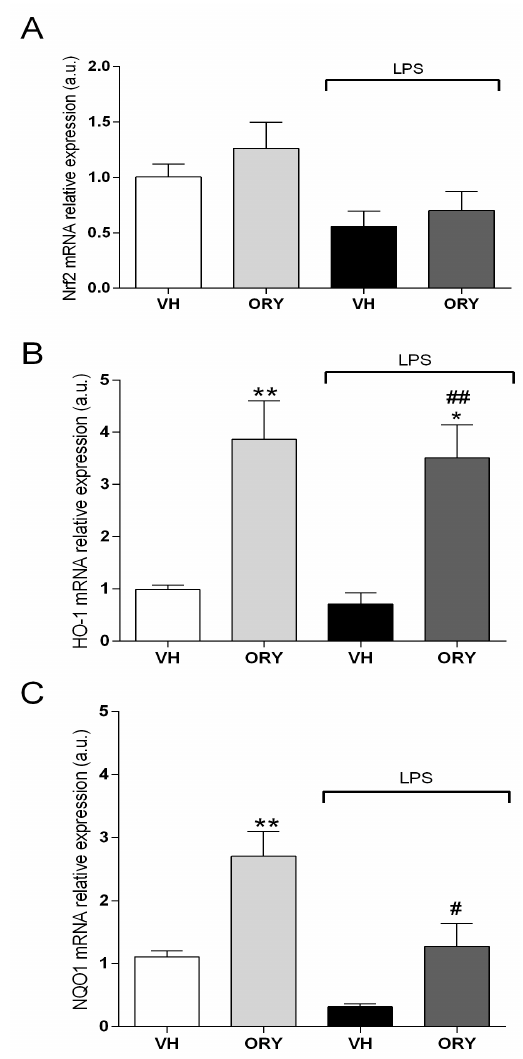
Figure 4. Graphic representation of quantitative RT-PCR data obtained from RNA extracted from VH, ORY, LPS, and ORY+LPS mice hippocampi. Data are expressed as the fold change of target genes (Nrf2 in ( A ), HO-1 in ( B ) and NQO1 in ( C )) normalized to the internal standard control gene ( β -Actin). Data are shown as the mean ± S.E.M. One-way ANOVA tests with the Newman–Keuls post-test were used to determine statistical significance, * p < 0.05 and ** p < 0.005. VH, # p < 0.05, and ## p < 0.005 vs. LPS. VH: vehicle; ORY: γ -oryzanol; LPS: lipopolysaccharide.